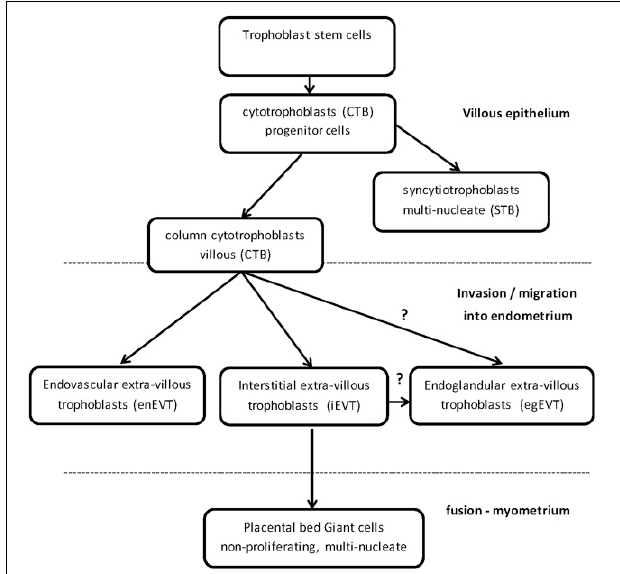
FIGURE 1 | Trophoblast stem cells differentiate into specialized trophoblast